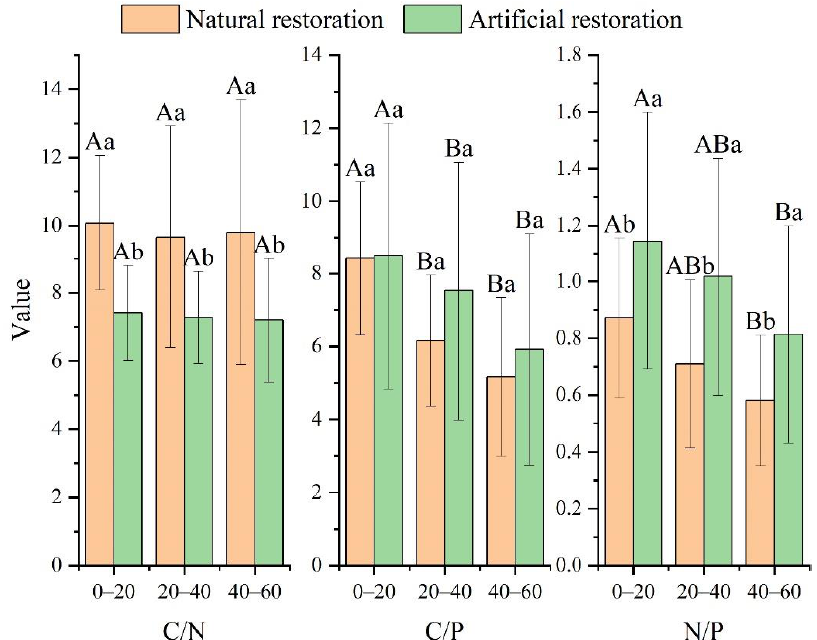
Figure 2. The metrological measurement comparison of SOC, TN and TP in soil. Note: Different capital letters indicate significant soil index differences between different soil layers using the same restoration method ( p < 0.05).